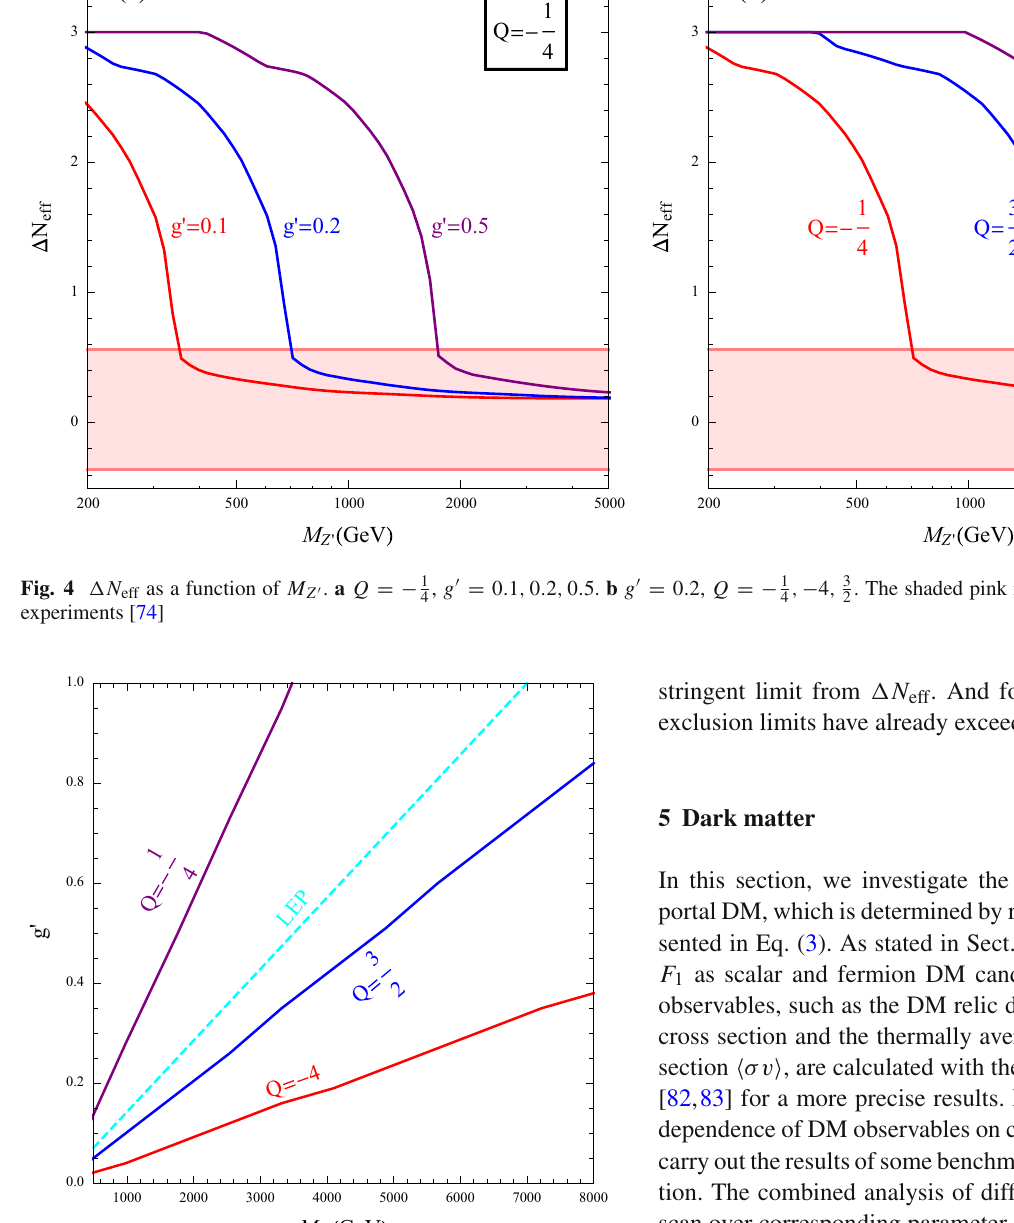
Fig. 5 (cid:3) N eff exclusion limit in the g (cid:2) − M Z (cid:2) for Q = − 1 dashed line corresponds to the LEP limit in Eq. (8)